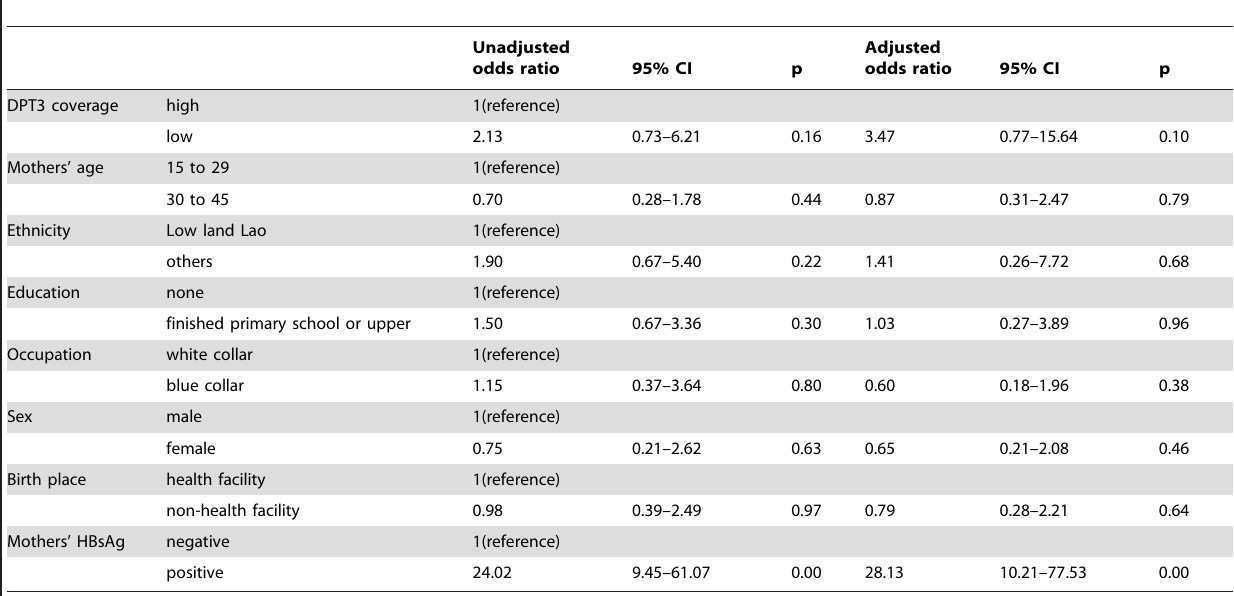
Table 3. Unadjusted and adjusted odds ratio for being HBsAg positive among children from five to nine years old in Lao PDR by selected background